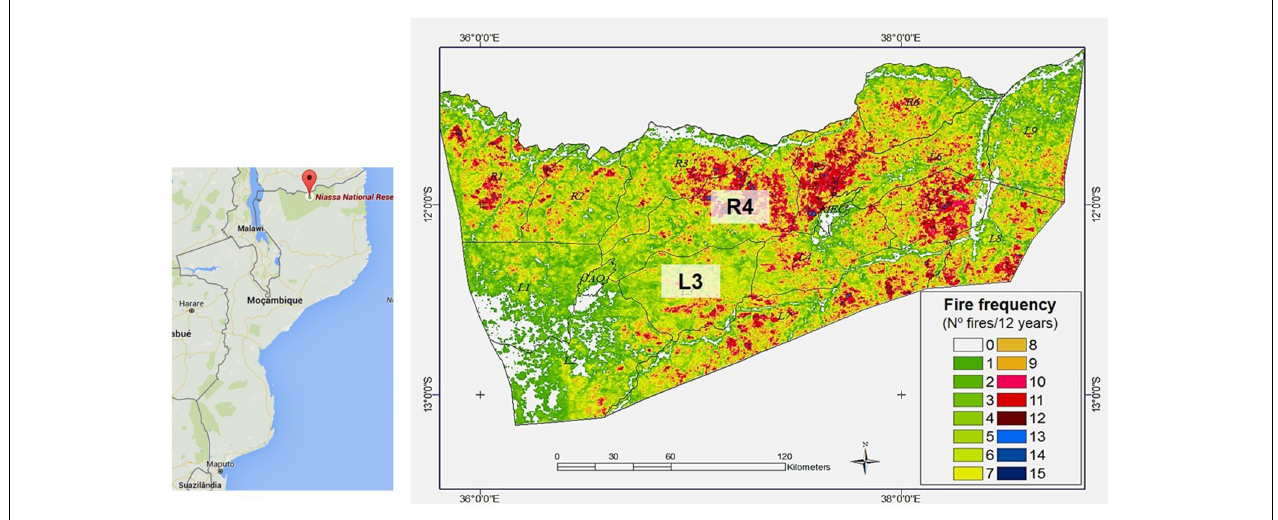
FIGURE 1 | Niassa National Reserve (NNR) fire areas map: L3 (LFF) and R4 (HFF) corresponds to B. boehmii sampling areas (Cangela, 2014).